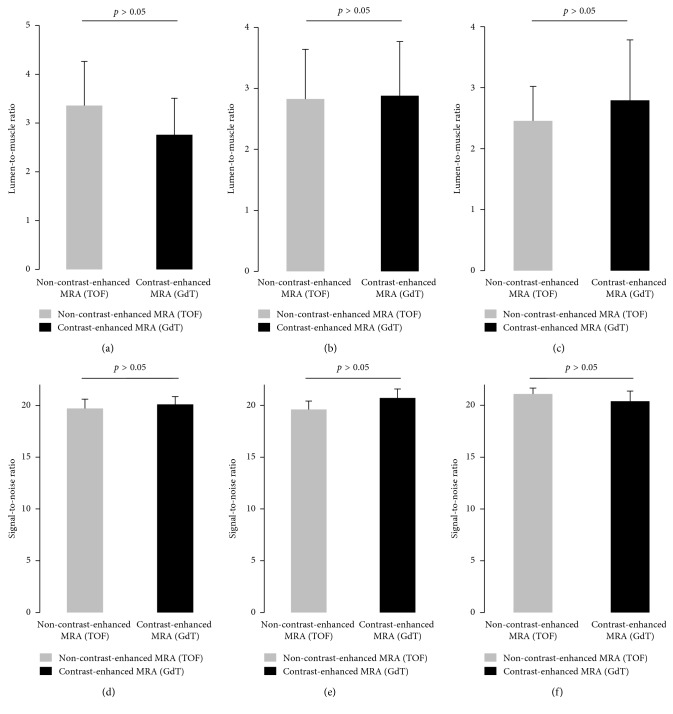
Lumen-to-muscle ratio and signal-to-noise measurements on of the aorta, brachiocephalic artery, and carotid artery on non-contrast-enhanced and contrast-enhanced MR angiographies. Lumen-to-muscle ratio (LMR) and signal-to-noise ratio (SNR) measurements were performed in the same animal at the same location in both non-contrast-enhanced magnetic resonance angiography (MRA) time-of-flight (TOF) and contrast-enhanced magnetic resonance angiography (MRA) gadofosveset-trisodium (GdT) images. For the aorta, lumen-to-muscle ratio measurements yield higher value for the non-contrast-enhanced MRA (TOF) compared to the contrast-enhanced MRA (GdT) (3.36 ± 0.91 vs. 2.76 ± 0.75). Difference did not reach statistical significance (p > 0.05). For the brachiocephalic artery, LMR values were comparable between the non-contrast-enhanced and contrast-enhanced MRA (2.83 ± 0.82 vs. 2.88 ± 0.89). For the carotid artery, the LMR of the non-contrast-enhanced MRA was lower compared to the contrast-enhanced MRA (2.45 ± 0.56 vs. 2.79–0.99). Difference in LMRs and SNRs between the two techniques was not significantly different (p > 0.05).